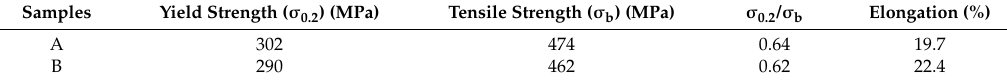
Table 2. Tensile properties of Al-Cu-Mg-Ag alloy sheet.